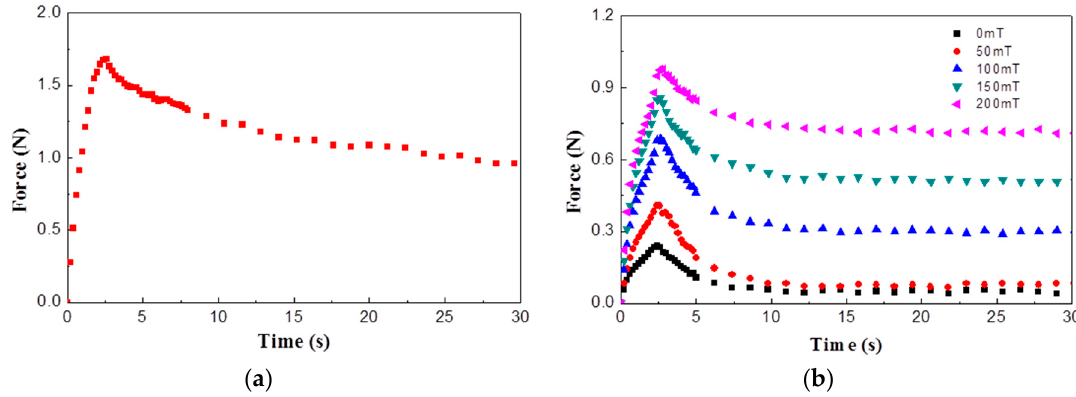
Figure 5. Measured reaction force results; ( a ) polyurethane foam; ( b ) magneto-rheological (MR) fluid.